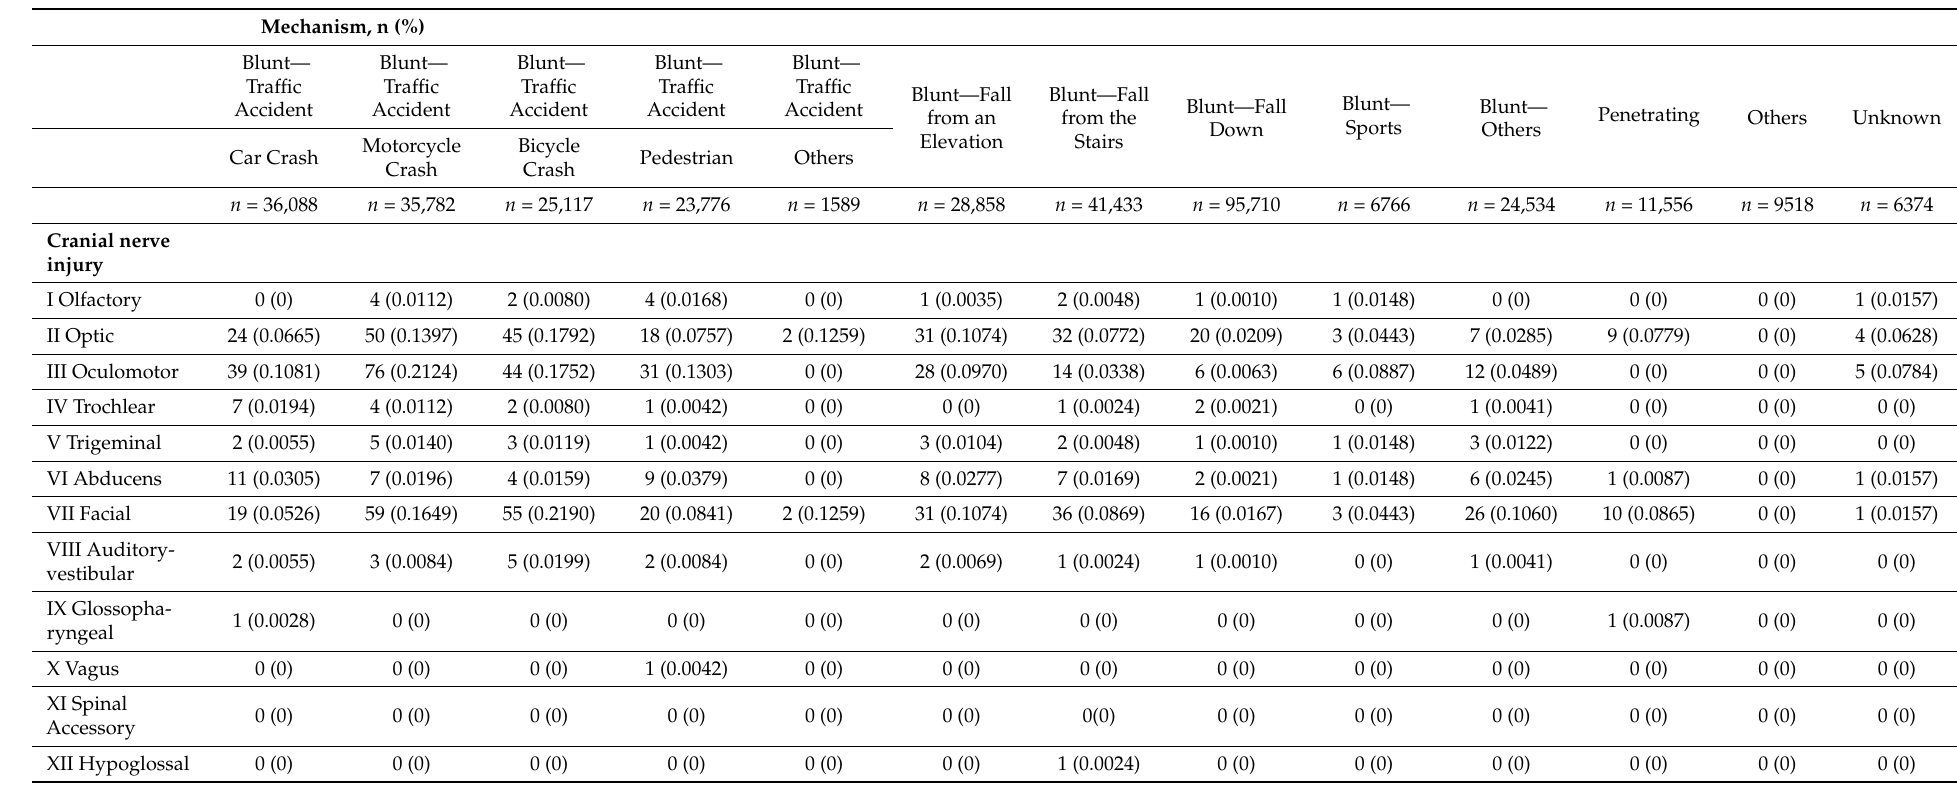
Table 2. Incidence of cranial nerve